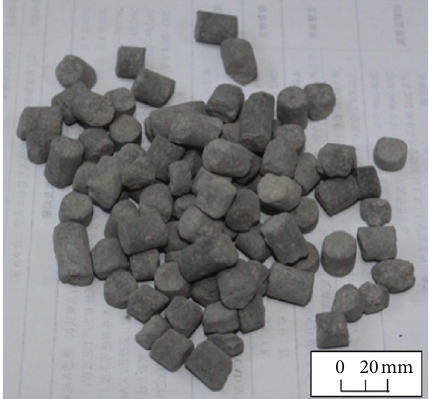
Figure 1: Morphology of the coal gangue ceramsite used in this